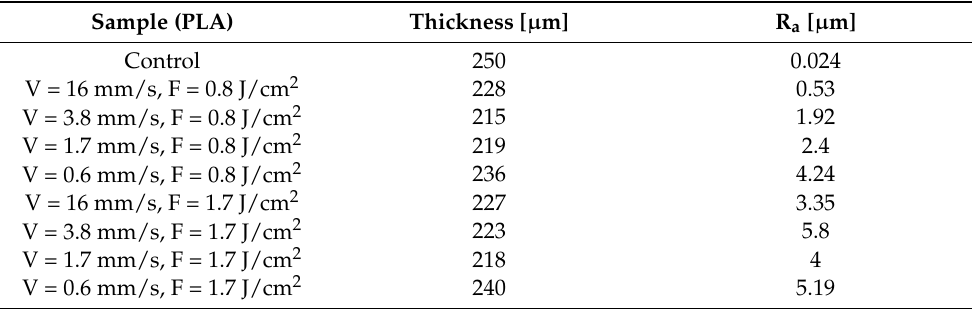
Table 2. Thickness [ µ m] and Roughness (Mean average roughness (R a ) and Areal surface